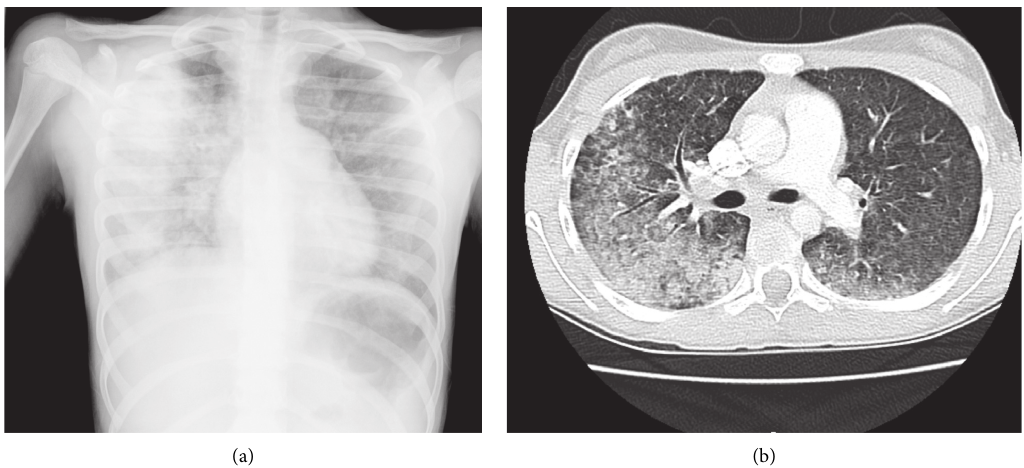
Figure 2: Chest X-ray (a) and CT scan (b) showing signs of alveolar hemorrhage, Case